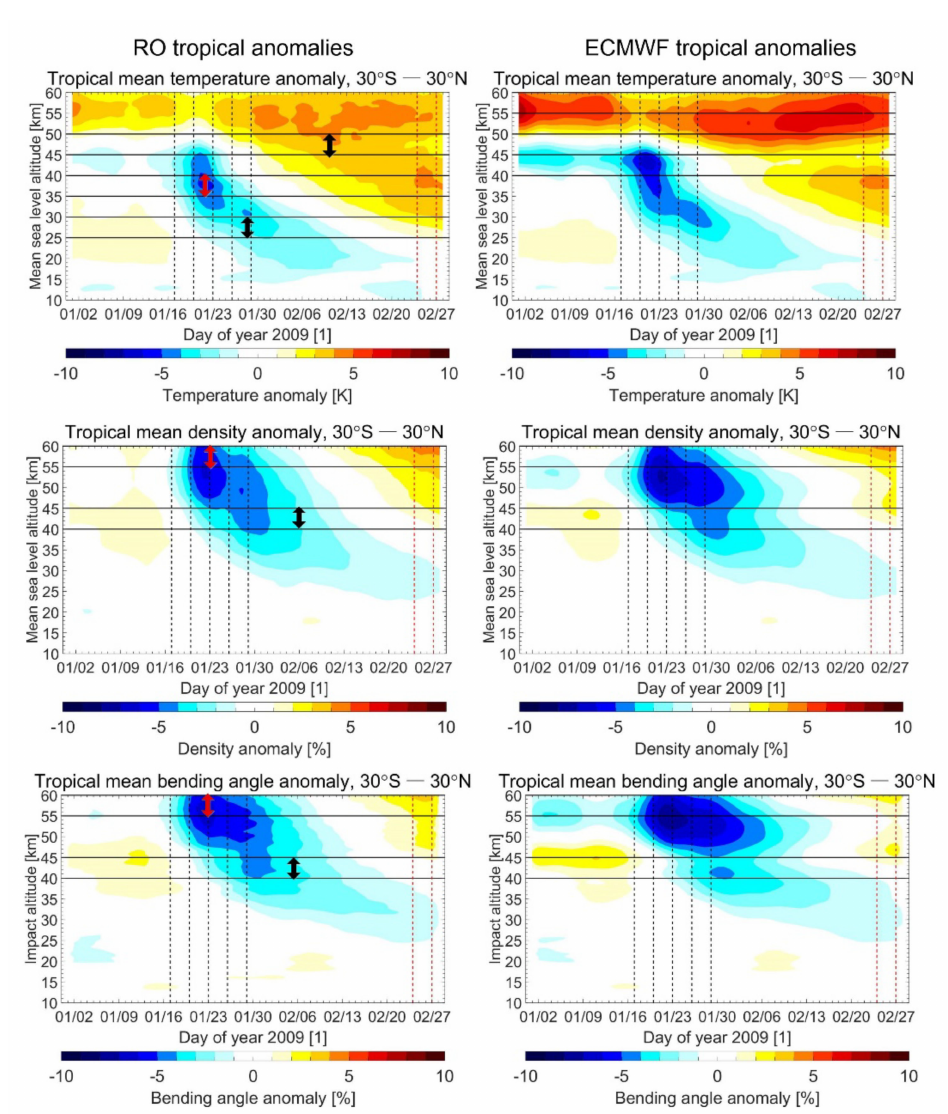
Figure 3. Temporal evolution of RO temperature (first row), density (second), and bending angle (third) tropical mean (left panels) and ECMWF tropical mean anomaly profiles (right panels). Red double-sided arrows indicate response altitude layers where the largest negative anomalies were detected; vertical mean anomalies within this altitude layer, as well as those within altitude layers as shown by black arrows will be used for illustration in figures in Section